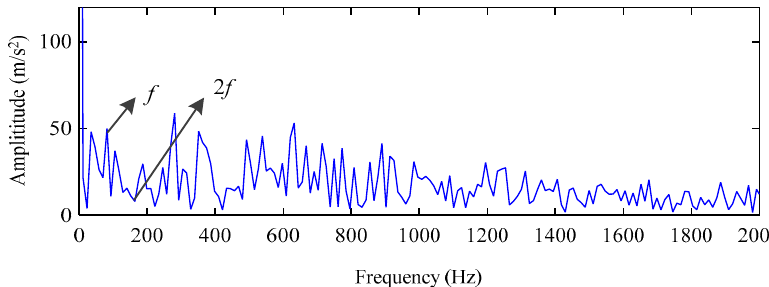
Figure 10. Envelope spectrum of optimal component by using EMD.